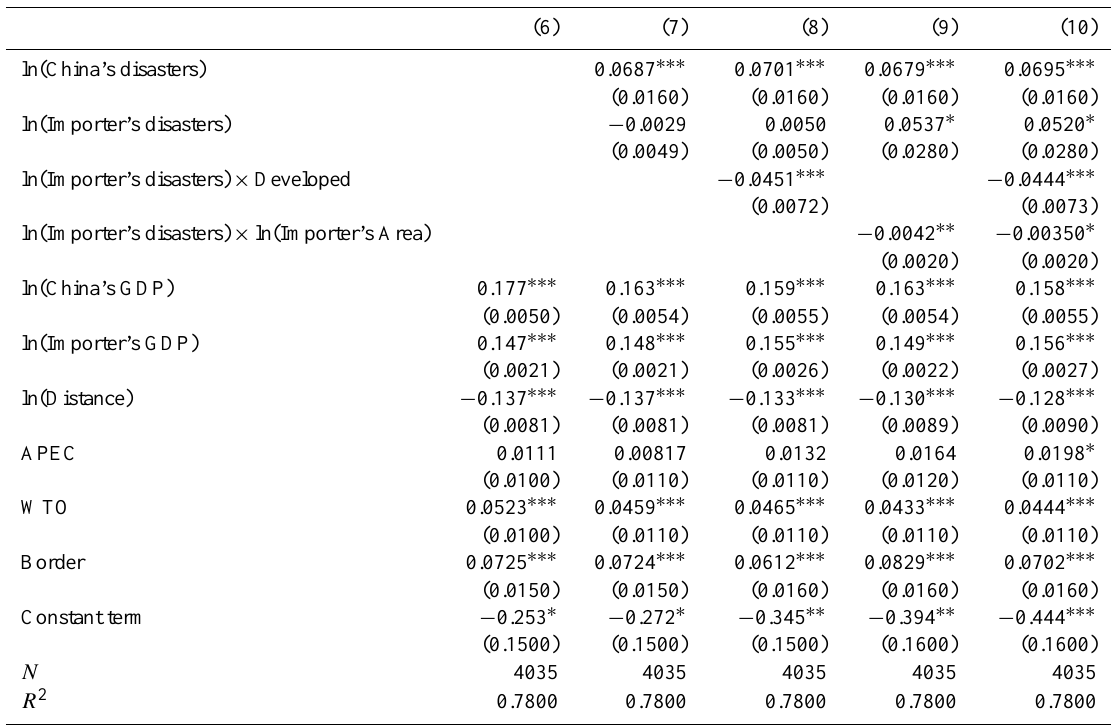
Table 6. Regression results for China as an exporter (1980–2012).